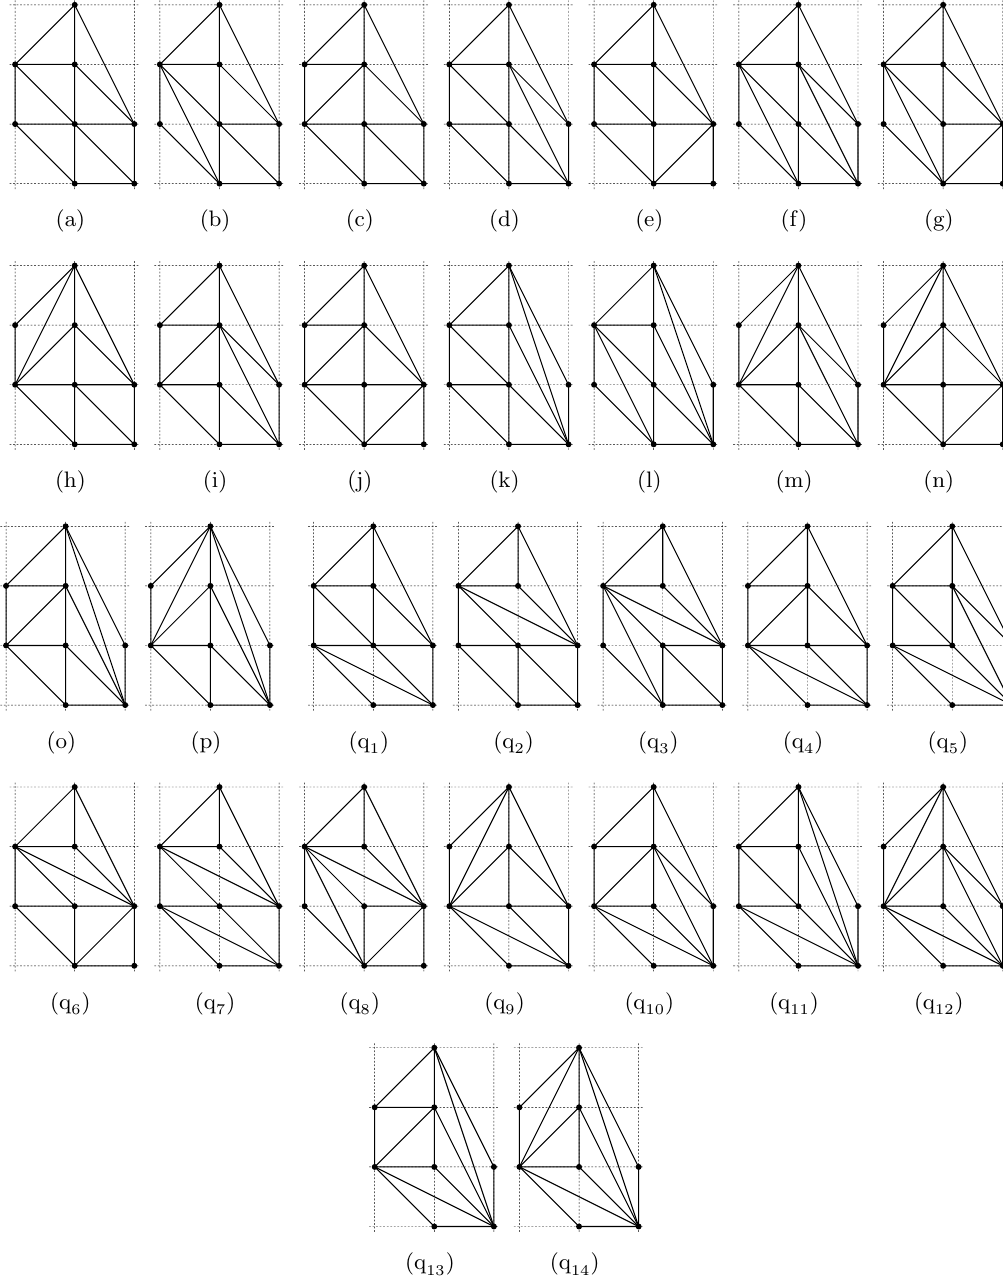
Figure 28 . The 30 crepant singularities of the E 32 ; 1 singularity. The (cid:12)rst 16, (a)-(p) admit a vertical reduction, corresponding to chambers of the SU(3) 2 N f = 2 gauge theory.